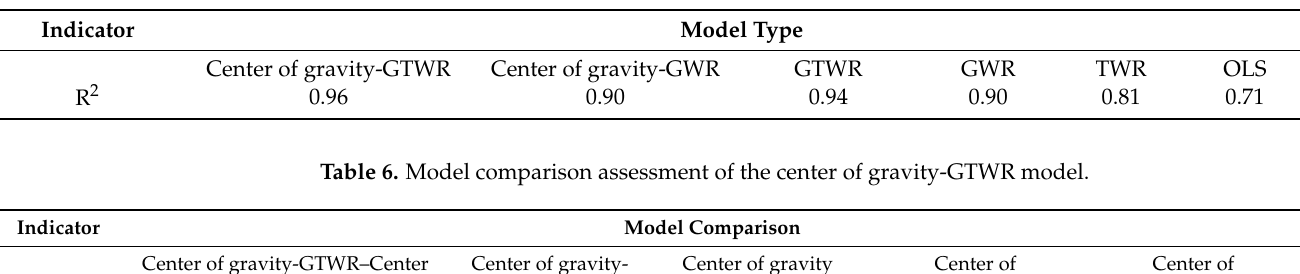
Table 5. Auxiliary validation of the center of gravity-GTWR model.